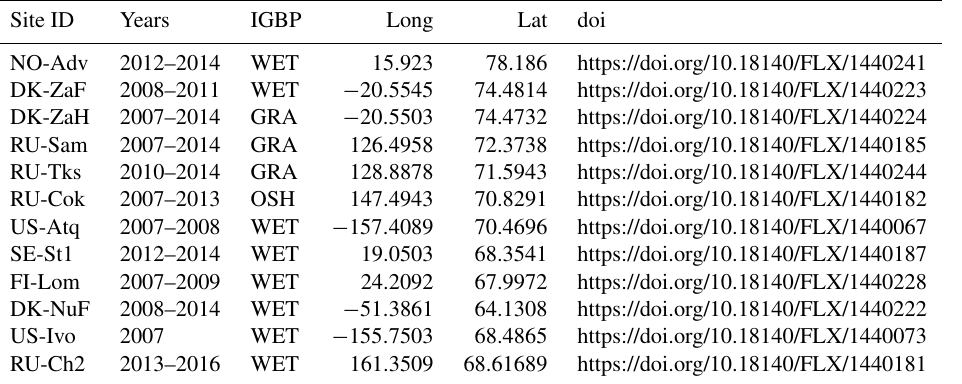
Table A1. Sites and years used for a comparison of eddy-covariance derived GPP, SIF footprints within 30km radius of the tower as well as the modelled GPP from the closest 0.5 ◦ grid